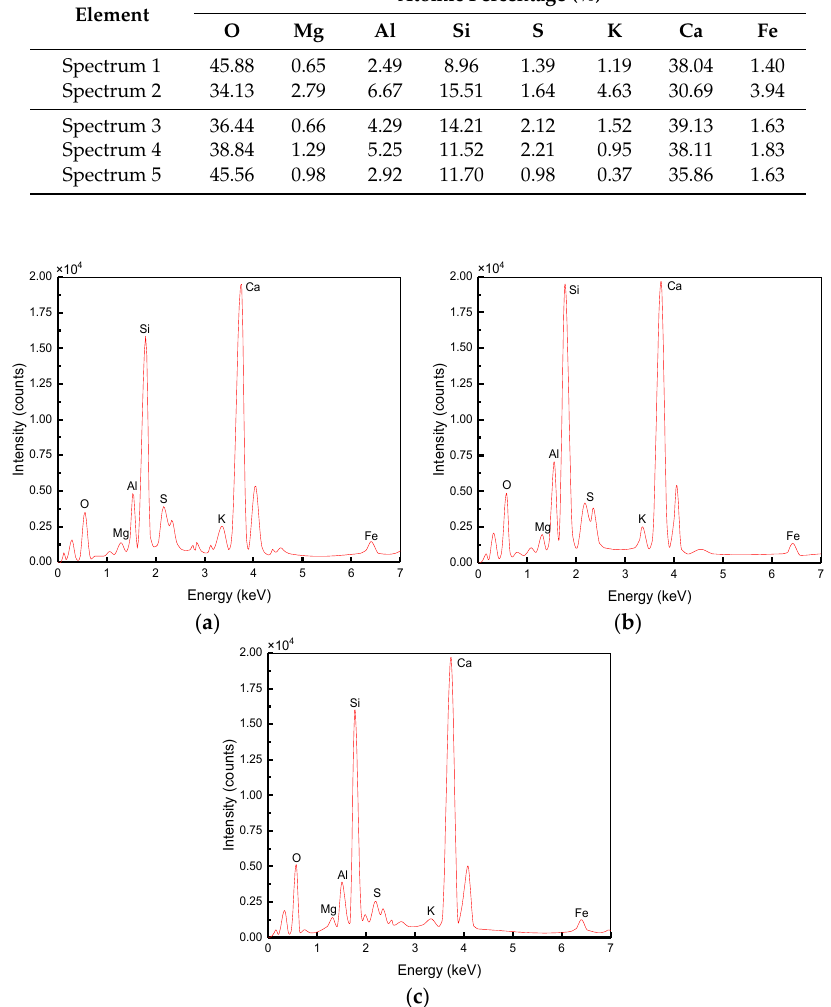
Figure 25. Energy spectrum in the ITZ of different concretes: ( a ) Spectrum3: Energy spectrum in the ITZ of BC; ( b ) Spectrum4: Energy spectrum in the ITZ of SC; ( c ) Spectrum5: Energy spectrum in the ITZ of BSC1. Table 8. The atomic percentage of different energy spectrums.